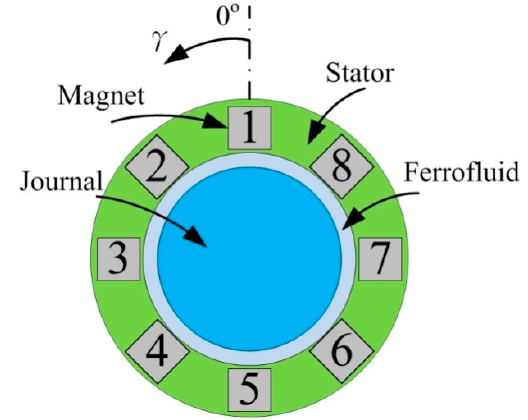
Figure 1. The experimental platform.